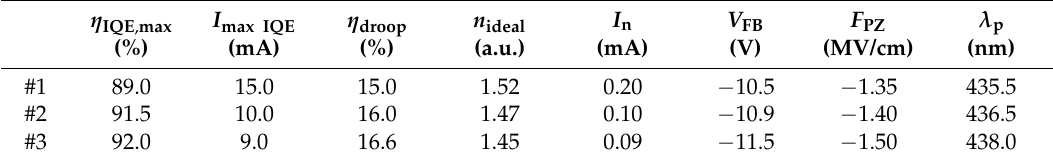
Table 1. Summary of optoelectronic performances of the